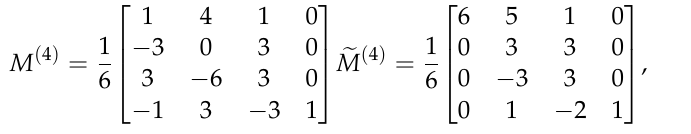
, where t and t represent the 1 2 represents